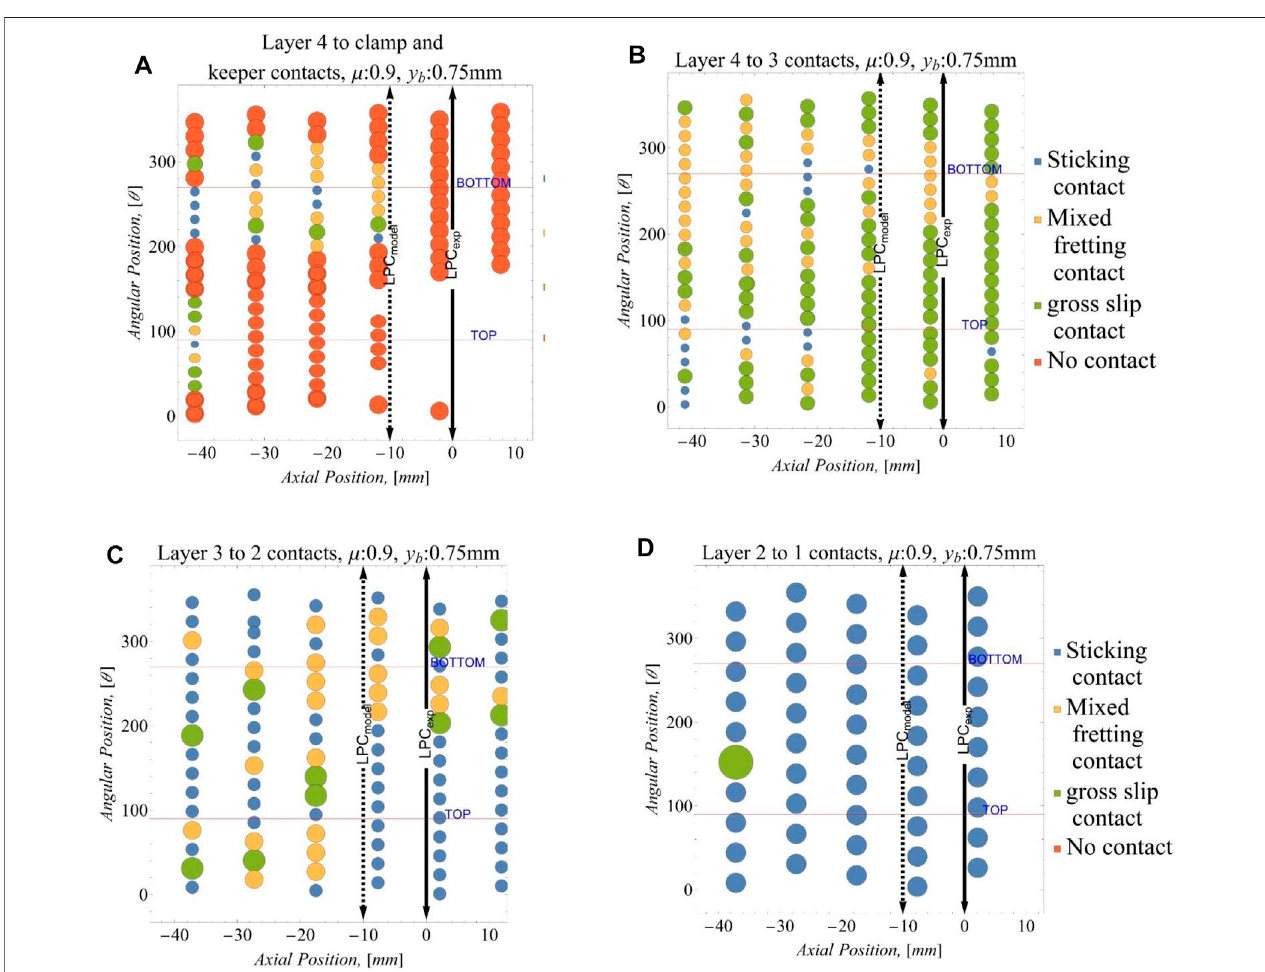
FIGURE 11 | Indicator function G(E) for (A) layer 4 to clamp contacts, (B) layer 4 to layer 3 contacts, (C) layer 3 to layer 2 contacts, and (D) layer 2 to layer 1 contacts.